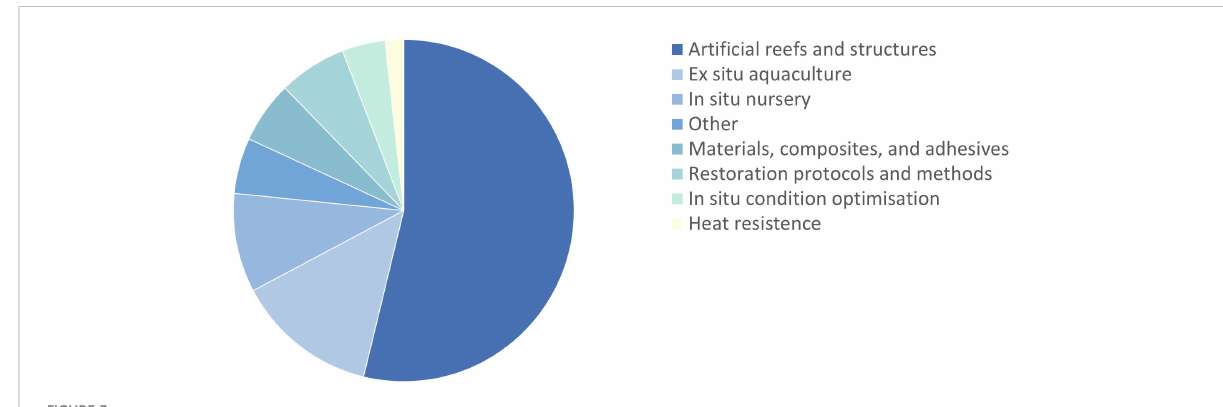
FIGURE 3 Categories of patents based on scope of